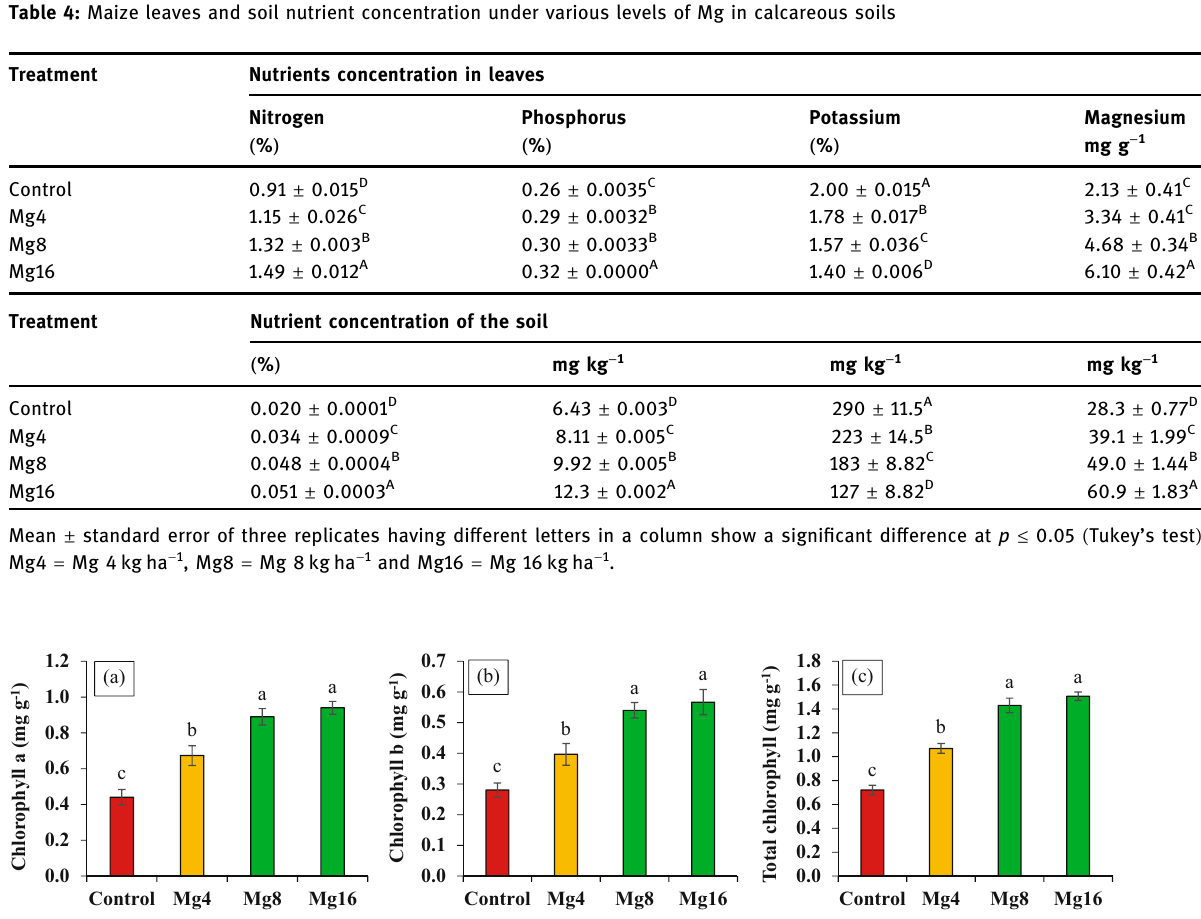
Figure 2: Chlorophyll contents ( chlorophyll a = ( a ) , chlorophyll ( b ) and total chlorophyll ( c )) in maize cultivated under various levels of Mg in calcareous soils. Red bar indicates minimum, orange bar indicates medium and green bar indicates the maximum synthesis of